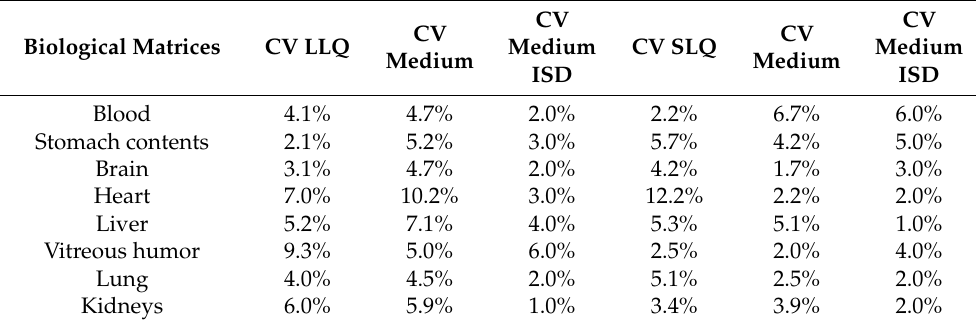
Table 15. Coefficient of variation (CV) of the lower limit of quantification (LLQ) and the superior limit of quantification (SLQ), as well as the average CV (average of the CV of the other points of the calibration curve), and of the internal standard (ISD) in the different matrices, expressed in percentage of 3-OH-carbofuran.